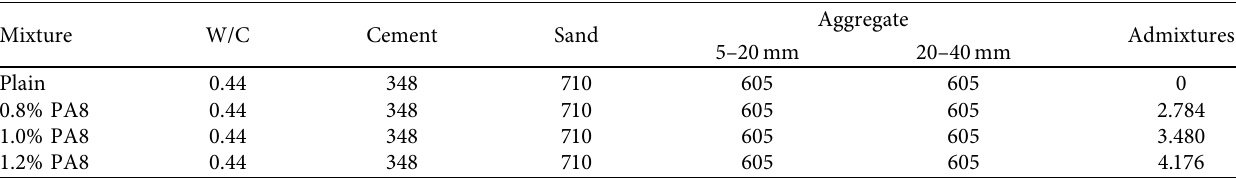
Figure 2: The cement material used for making concrete specimens: (a) cement and (b) the cementitious permeable crystallization admixture (CPCA). Table 1: Material compositions of the concrete (unit: kg/m 3 ).